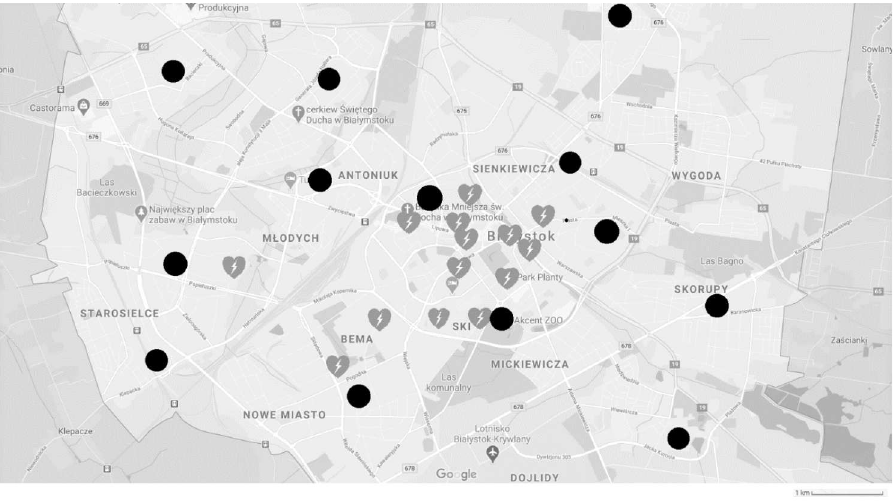
Figure 3. Current and optimal deployment of AED devices in